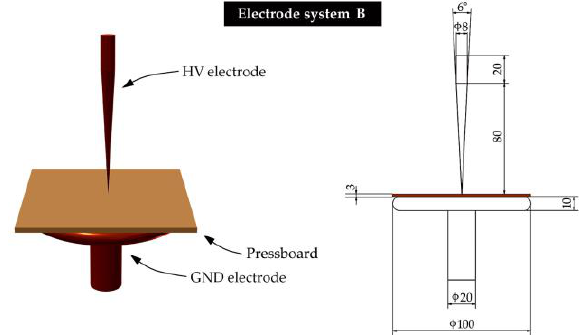
Figure 5. The applied electrode system for generation of surface discharges on a pressboard sample in oil with significant normal component of electric field — electrode system B.